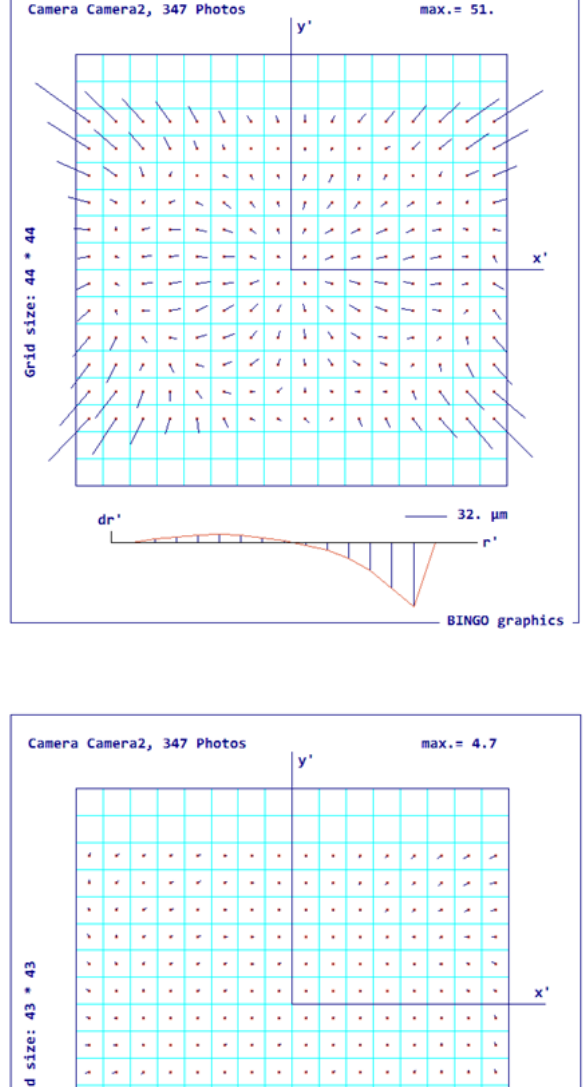
At the above stage further parameters were also included, which were individually selected for every camera by analyzing the remaining errors in the Implo program of BINGO. During this step two special parameters for medium format cameras and a parameter - which was developed especially for that camera type - were used.